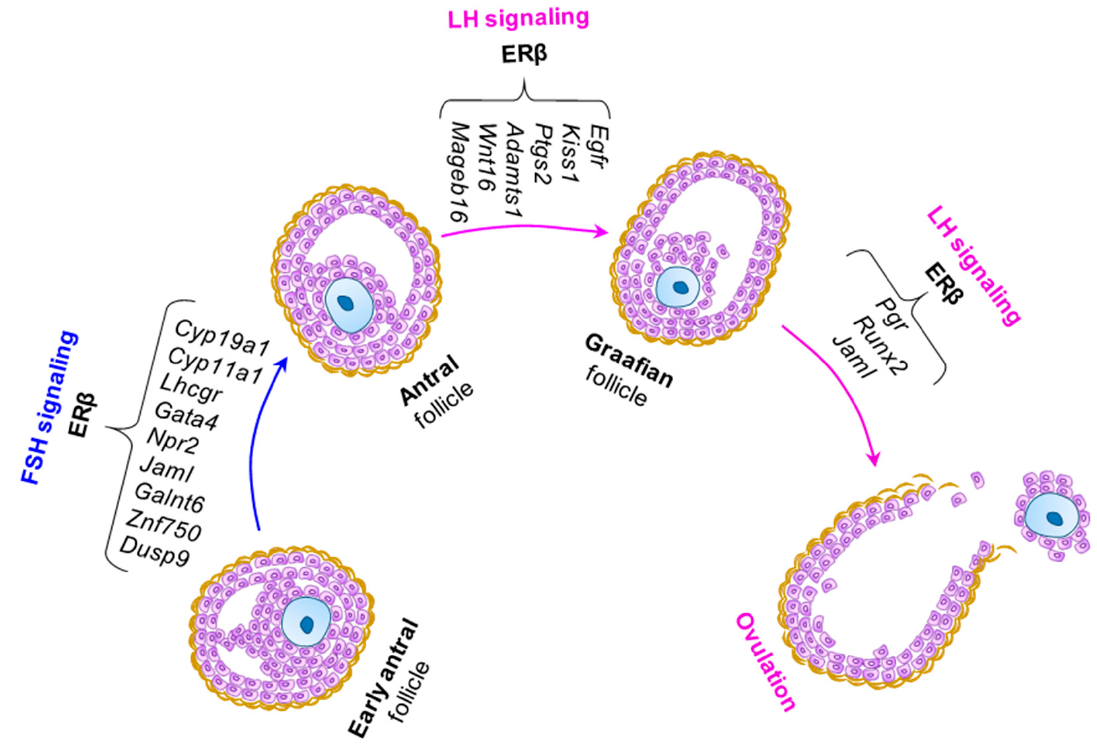
Figure 5. ER β regulation of gonadotropin responses. ER β is the predominant estrogen receptor in the ovary involved in transcriptional regulation of gene expression. While ER α is expressed in theca cells (TCs), ER β is expressed in granulosa cells (GCs). As GCs express both FSHR and LHCGR, we analyzed the role of ER β in gonadotropin-induced gene expression in GCs. We identified that a subset of PMSG (that activates FSHR) or hCG (that activates LHCGR) regulated genes failed to respond in the absence of ER β expression in GCs. In early antral follicles, expression of FSHR-induced genes including Cyp19A1 , Cyp11a1 , Lhcgr , Gata4 , Npr2 , Jaml , Galnt6 , Znf750 , and Dusp9 was dependent on ER β . Moreover, presence of ER β was found to be essential for the expression of LHCGR-induced genes, such as Egfr , Kiss1 , Ptgs2 , Adamts1 , Wnt16 , Mageb16 , Pgr , Runx2 , and Jaml . Disruption of ER β signaling results in dysregulation of these genes and is associated with failure of follicle maturation, and ovulation. As ovulation does not occur in the absence of ER β , the potential role of ER β in luteinization has not been studied.